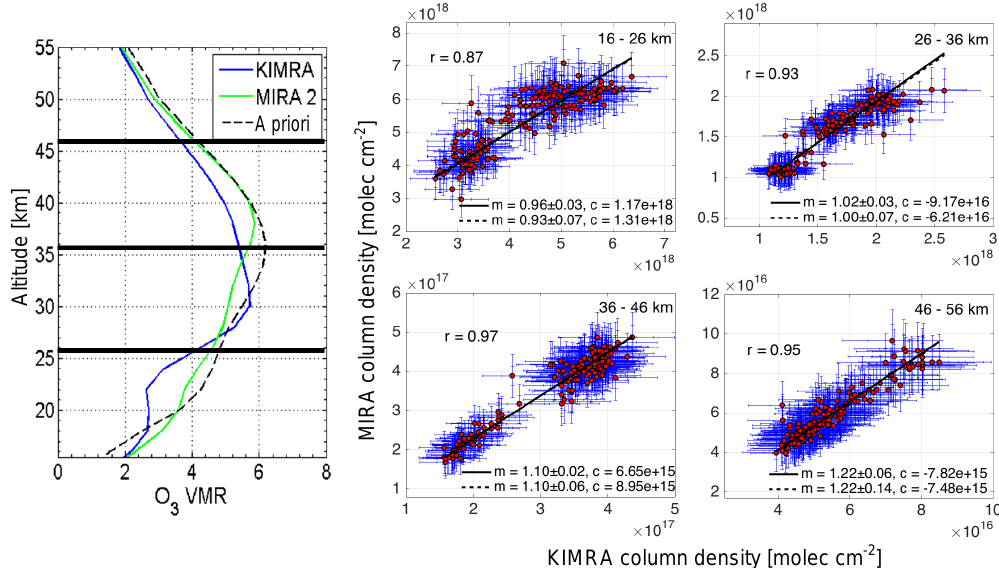
Figure 4. Left: same as left plot in Fig. 3 (in ppmv) but with markers showing the altitude separation of the partial columns. Right: scatter plot of the partial columns of coincident KIMRA and MIRA 2 data. The error bars show the two cases of error estimation for the ground-based instruments (see Sect. 4.2). Lines of best fit are shown for each case, with the dashed line indicating the case of the higher error estimate. The slope ( m ) and its standard error, and the intercept ( c ) for each line are shown. The correlation for each of the sets of partial columns is also